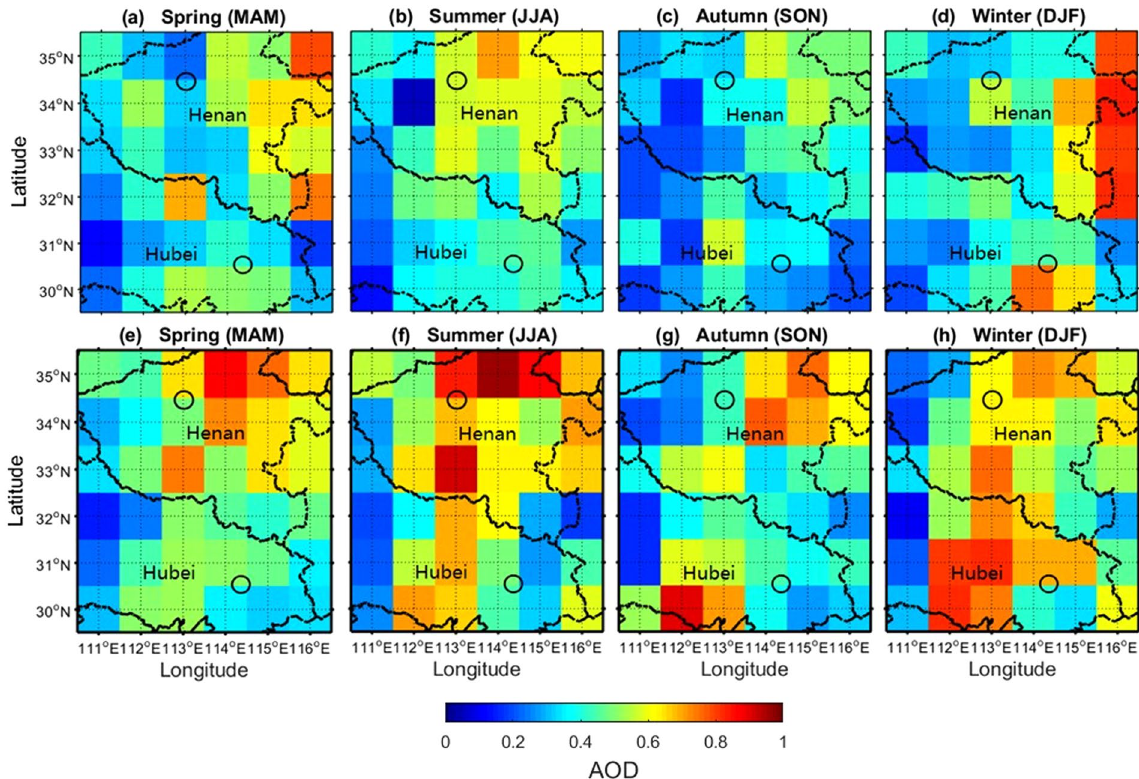
Figure 5. Seasonal mean distributions of ( a – d ) CALIPSO AODs and ( e – h ) MYD_DB AODs from November 2013 to December 2017 on 1° × 1° equal-angle grids. Black circle represents the ground-based